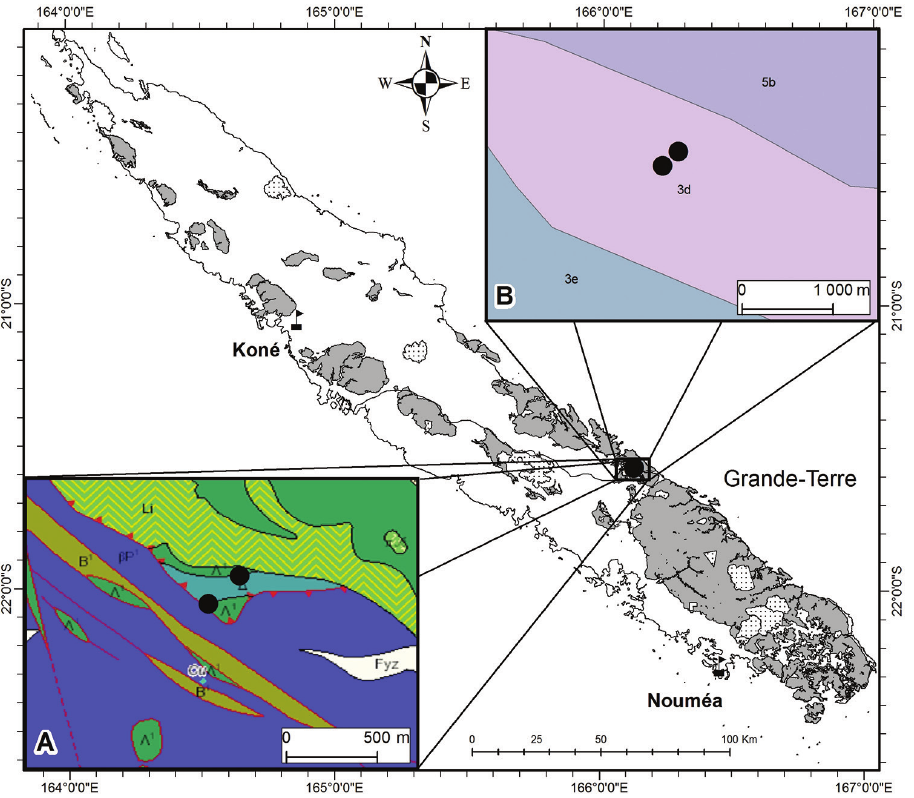
Figure 1. Distribution of Acropogon horarius Gâteblé & Munzinger sp. nov. mapped on the geological ( A ) and soil ( B ) GIS layers of the Petchécara Pass. Insert A, geology from Gouvernement de la Nouvelle-Calé- donie (2018): Λ 1 , serpentinites; Δ, amphibolites; B 1 , undifferentiated poly-metamorphic substrate; β P 1 , un- differentiated basalts and dolerites; Fyz, recent and extant alluvial; Li, listwanites. Insert B, soils from Fritsch (2012): 3d, haplic cambisol combined with lithic leptosol on peridotites; 3e, ferralic cambisol combined with haplic ferralsol on volcano-sedimentary and metamorphic rocks; 5b, posic ferralsol on